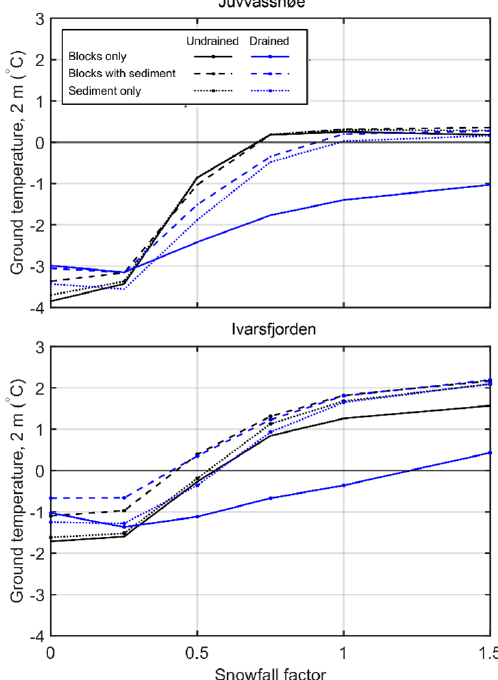
Figure 5. Equilibrium ground temperature at 2m depth for three idealized stratigraphies (Table 1) and different snowfall factors. Each data point represents one model run of one of the six scenarios at a certain snowfall factor.